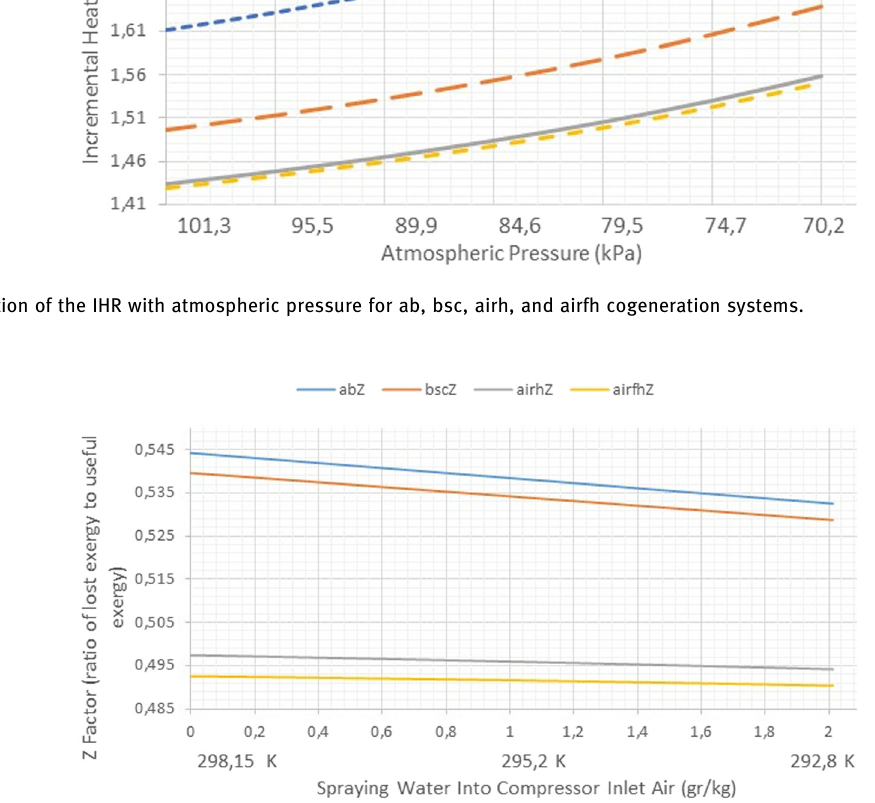
Figure 10: Variation of Z factor ( ratio of lost exergy to useful exergy ) with spraying water into compressor inlet air ( g/kg ) for ab, bsc, airh, and airfh cogeneration